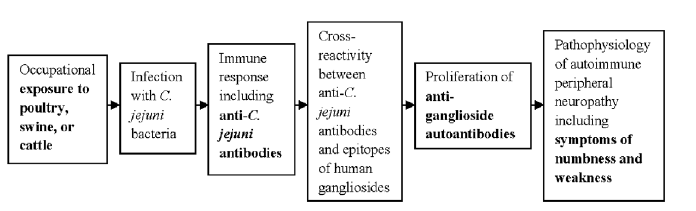
Fig 1. Schematic Depiction of Hypothesized Causal Pathway Between Occupational Exposure to Poultry, Swine, or Cattle and Development of Autoimmune Peripheral Neuropathy. Farmers and others who work with animals may be occupationally exposed to the avian commensal bacterium Campylobacter jejuni , which may result in infection and immune response. Molecular mimicry, or similarity in structure, between lipo-oligosaccharides (LOS) of C . jejuni bacteria and epitopes of human gangliosides may lead to the proliferation of anti-ganglioside autoantibodies and subsequent symptoms of autoimmune peripheral